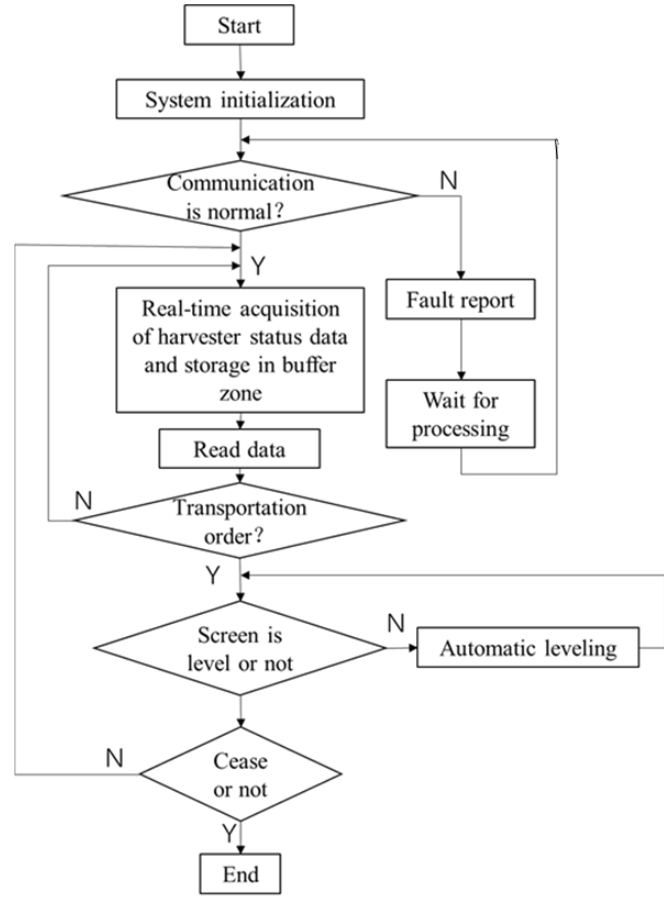
Figure 4. Main program control flow chart.